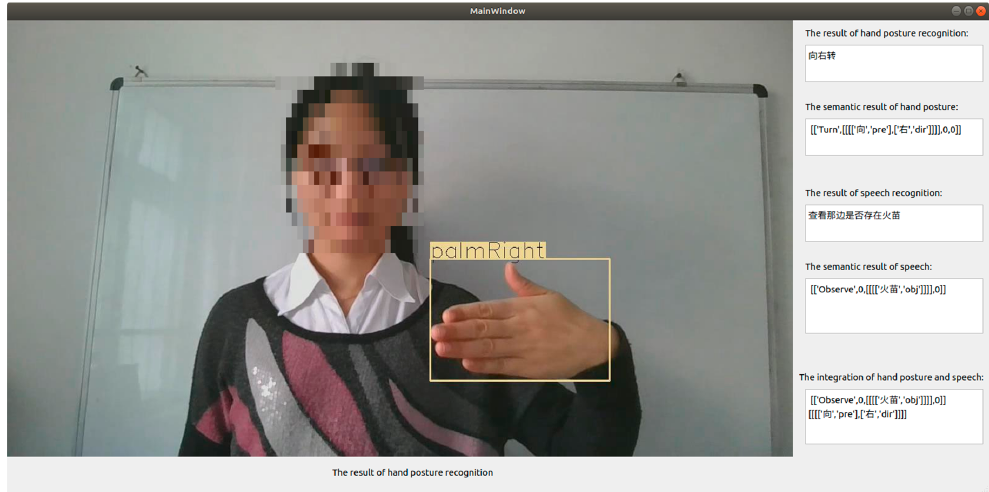
( b ) Figure 27. Example of comparison when the system correctly classifies the hand posture and when it fails. ( a ) The hand posture is incorrectly classified; ( b ) the hand posture is correctly classified.